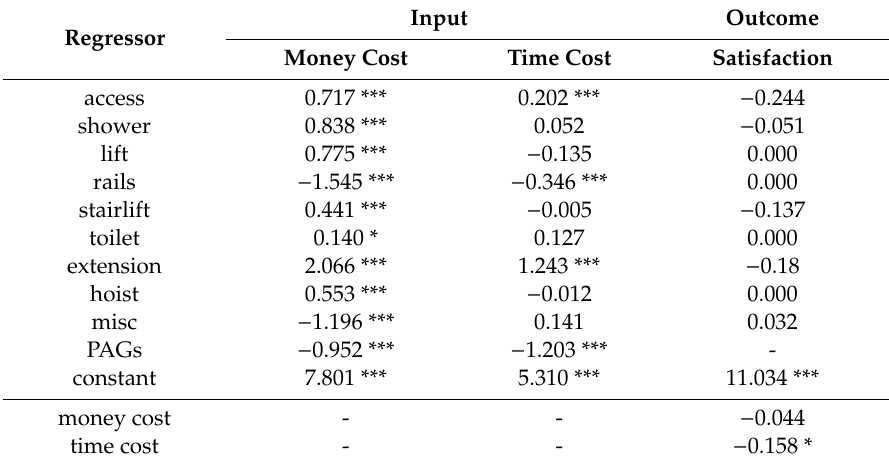
Table 3. Summary of the e ffi ciency evaluation (quantile